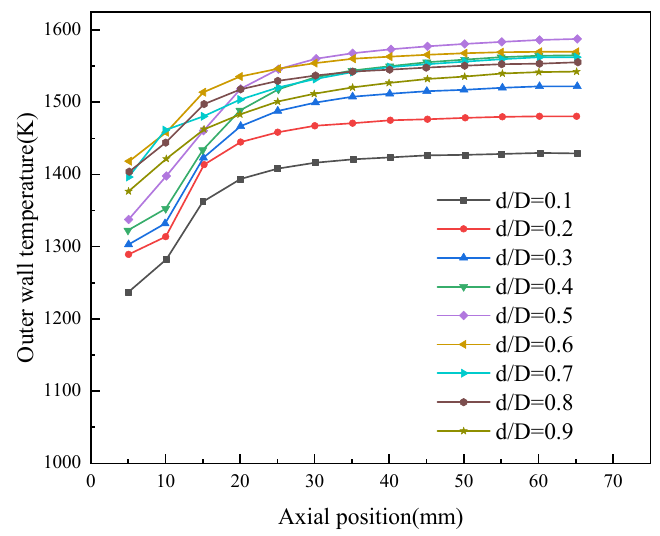
Figure 9. Wall temperature of different d/D porous media.